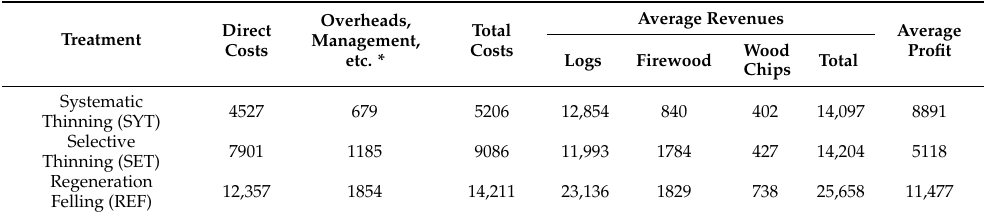
Table 2. Summary data of economic balance obtained by the models’ application as a function of the average weight of the tree for the three treatments (EUR ha − 1 ).